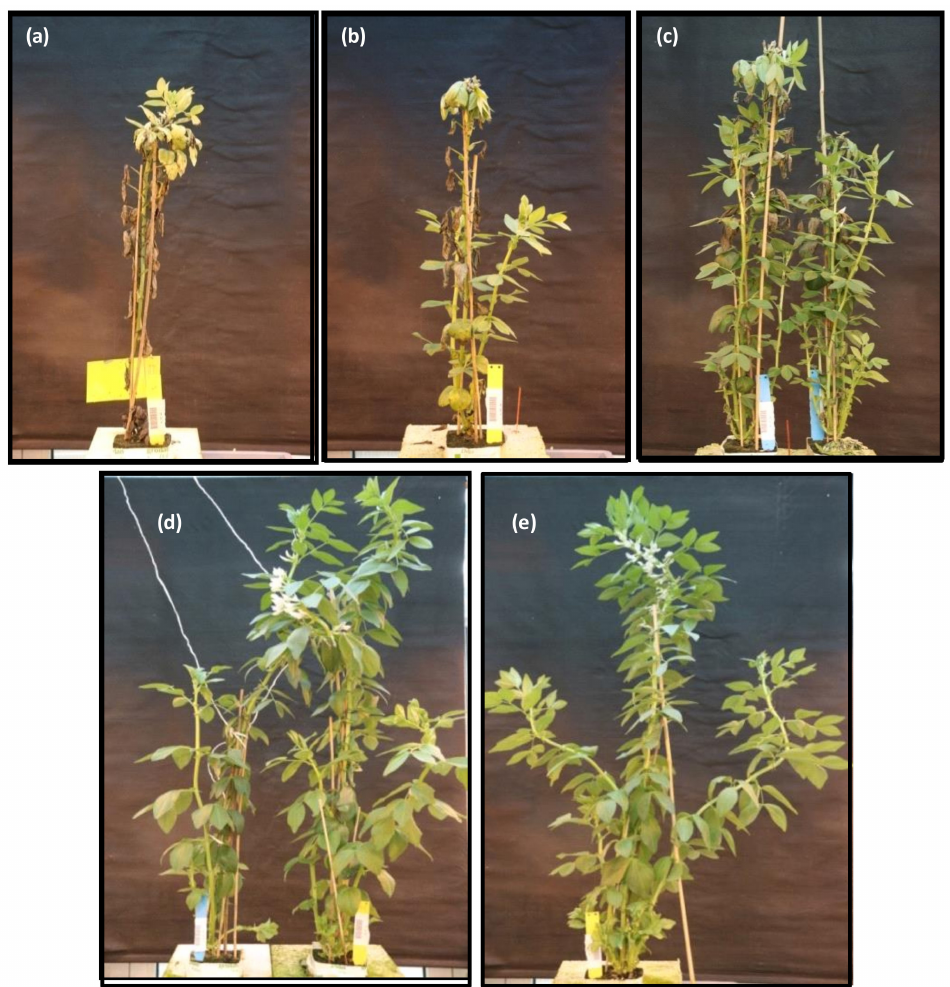
Figure 3. Phenotypes of wild-type ( a , e ) and PR10a faba bean lines TL-2 ( b ), and TL-3 ( c , d ) with ( a – c ) and without ( d – e ) salt stress for 29 days followed by 14 days without salt stress ( a